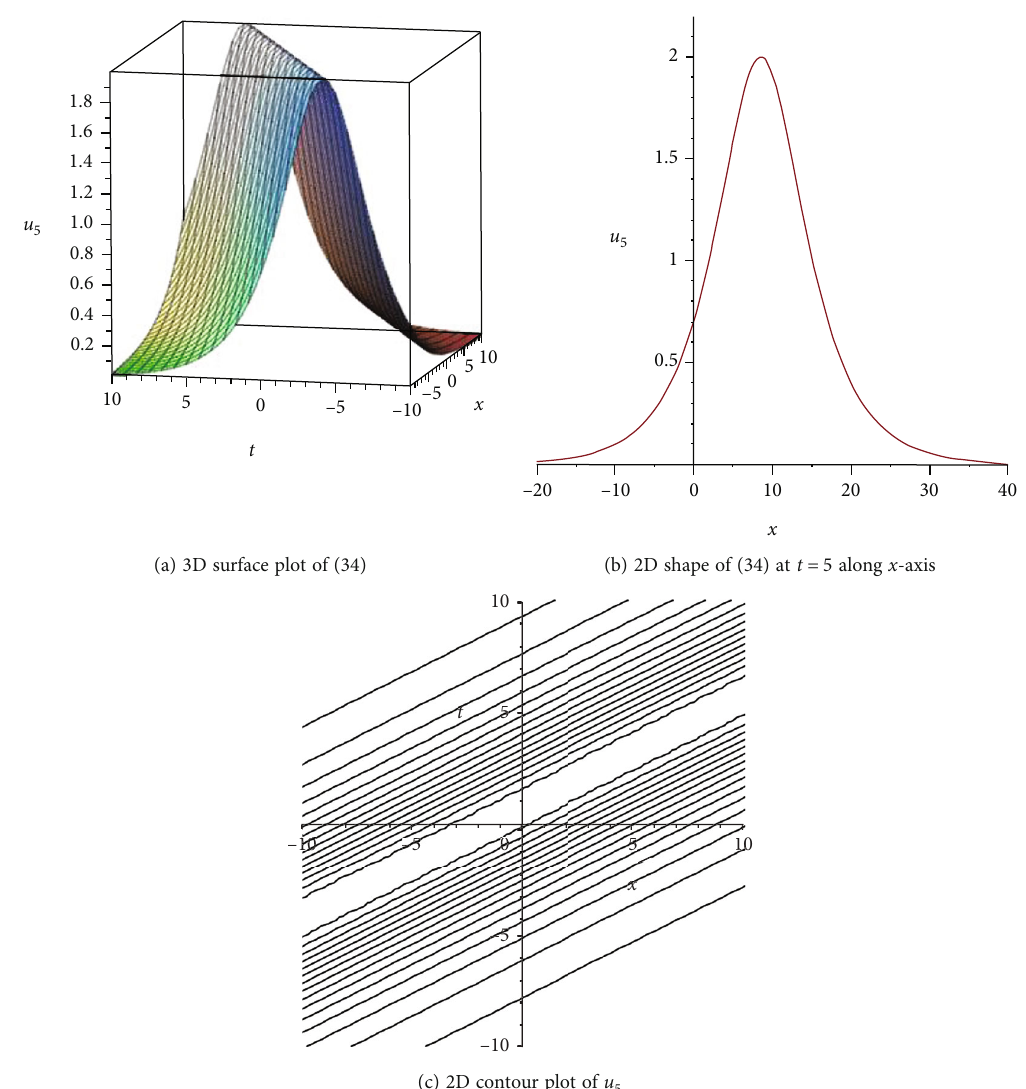
a = 0 : 1 , a = 0 : 2 , b = 0 : 24 , b 1 2 1 = 0 : 032 , σ = 0 : 0295 , σ = 0 : 059 , y = 1 , θ = 0 , and ξ 1 2 2